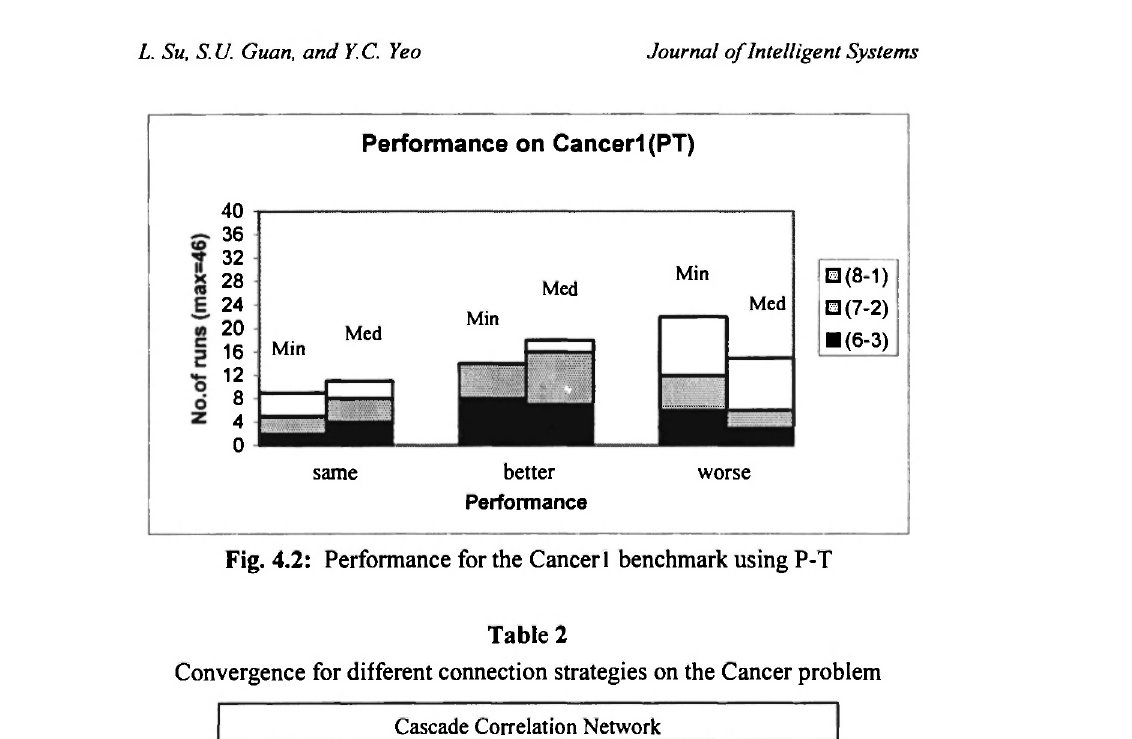
Convergence for different connection strategies on the Cancer problem Cascade Correlation